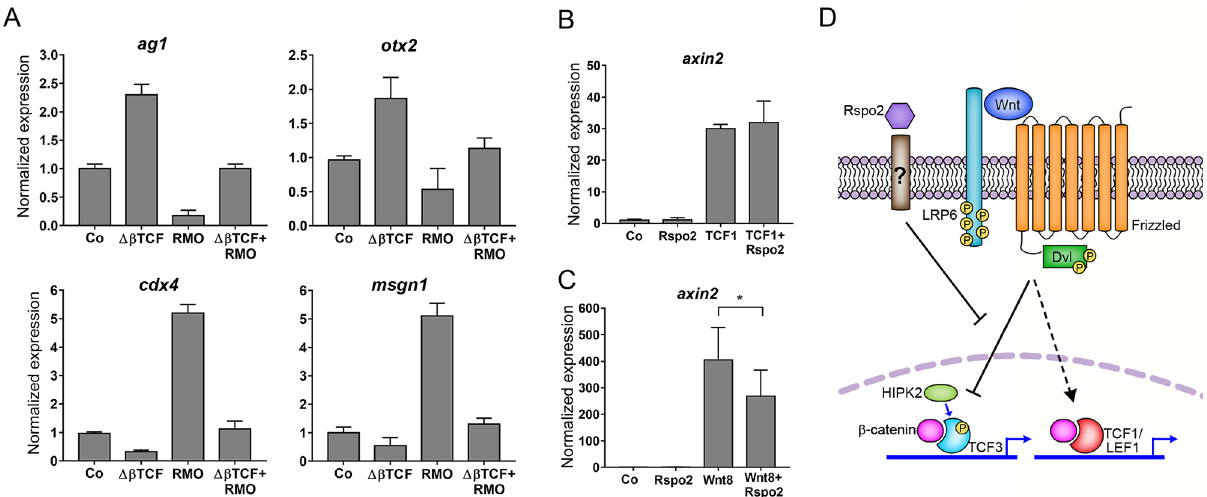
Figure 6. Rspo2 inhibits Wnt signaling through TCF3. ( A ) ∆βTCF3 RNA (10 pg) rescues ag1 , otx2, cdx4, and msgn1 expression in embryos injected with 10 ng of RMO ATG . B, C, Rspo2 inhibits axin2 upregulation by Wnt8 ( C ) but not TCF1 ( B ) in ectoderm cells. Embryos were injected with Wnt8 (20 pg) or TCF1 (100 pg) RNA without or with Rspo2 RNA (300 pg). Ectoderm explants were prepared at stage 8.5–9 and analyzed at stage 13. RT-qPCR analysis was carried out in triplicates for axin2 and normalized to eef1a1 levels . Means + /− s.d. are shown. Graphs are representative of 2–4 independent experiments. Statistical significance has been assessed by Student’s t test, *, p < 0.05. D, Model for Rspo2-mediated repression. Rspo2 functions via an unknown receptor to inhibit Wnt target gene activation mediated by TCF3 phosphorylation but not TCF1-dependent transcriptional